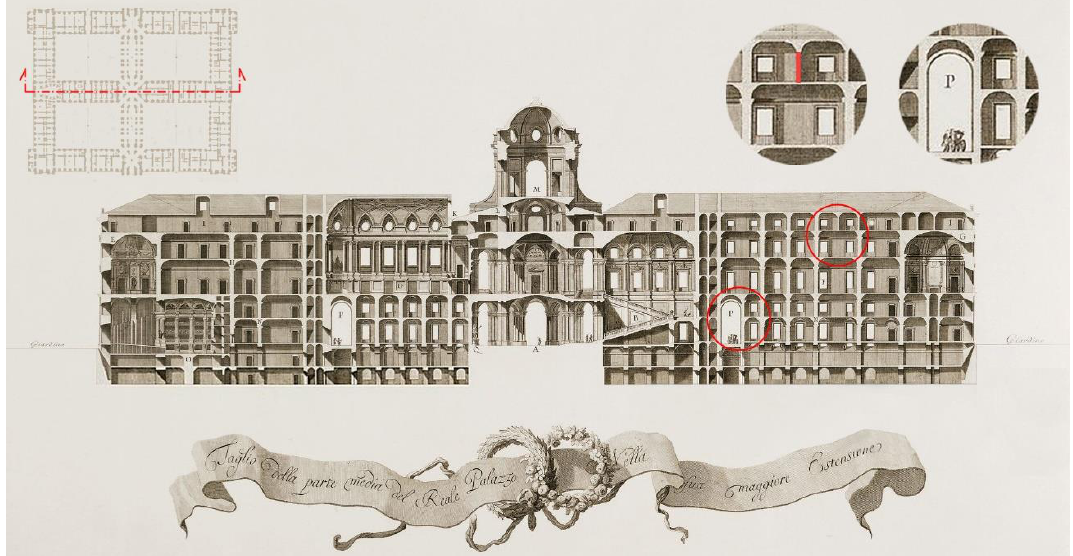
Figure 8. Cross section of the Royal Palace of Caserta. In red are highlighted the “in falso” walls and some of the double-space levels (1700–1773). Re-elaboration from De Agostini Picture Library, L. Romano at www.gettyimages.it.